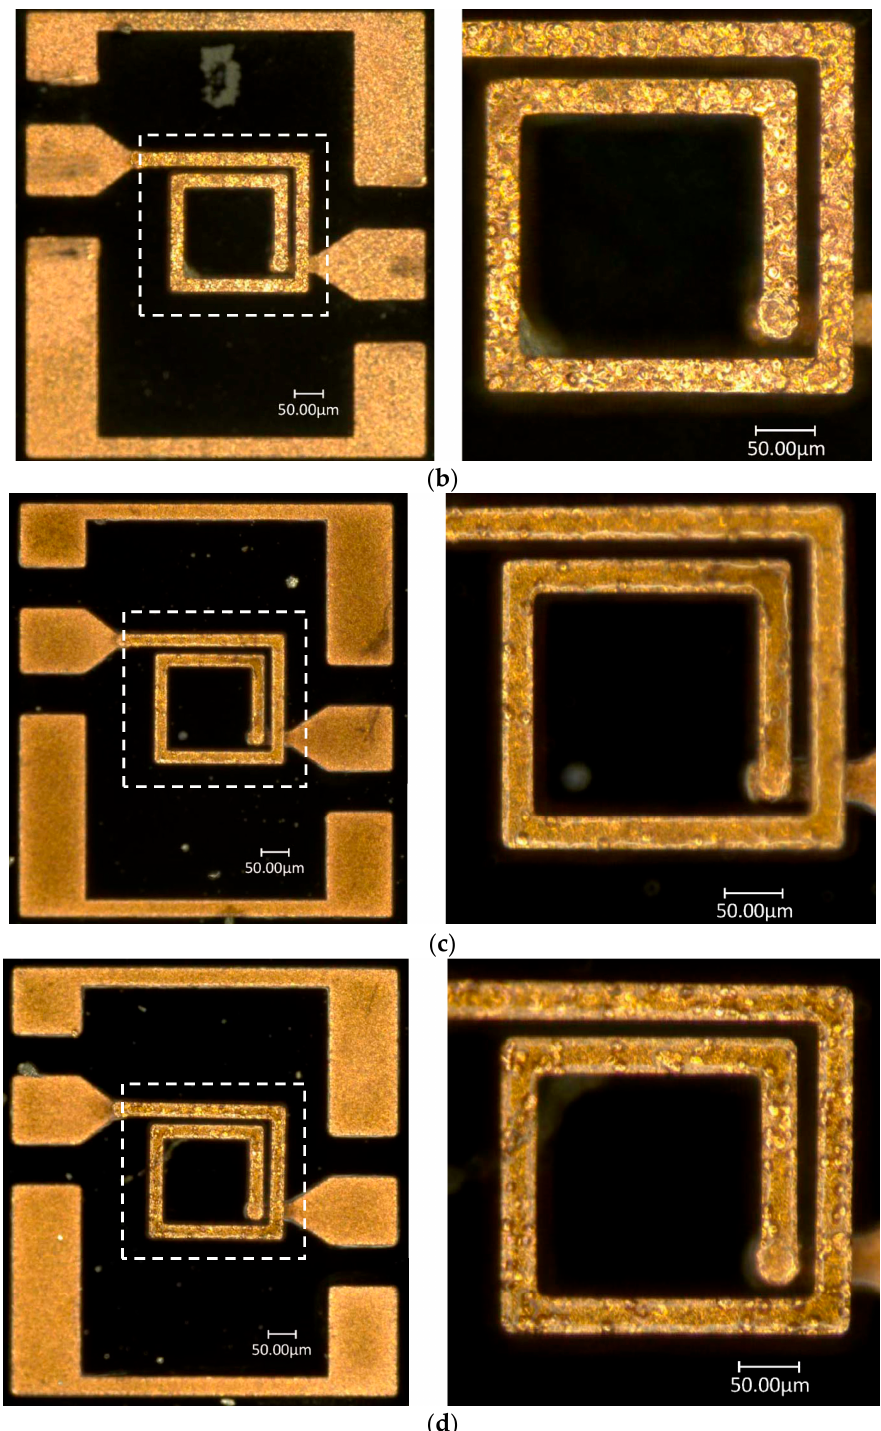
Figure 10. The inductors after shock tests for three shock amplitudes. ( a ) Before shock test. ( b ) 12,500 g. ( c ) 13,900 g. ( d ) 16,600 g.